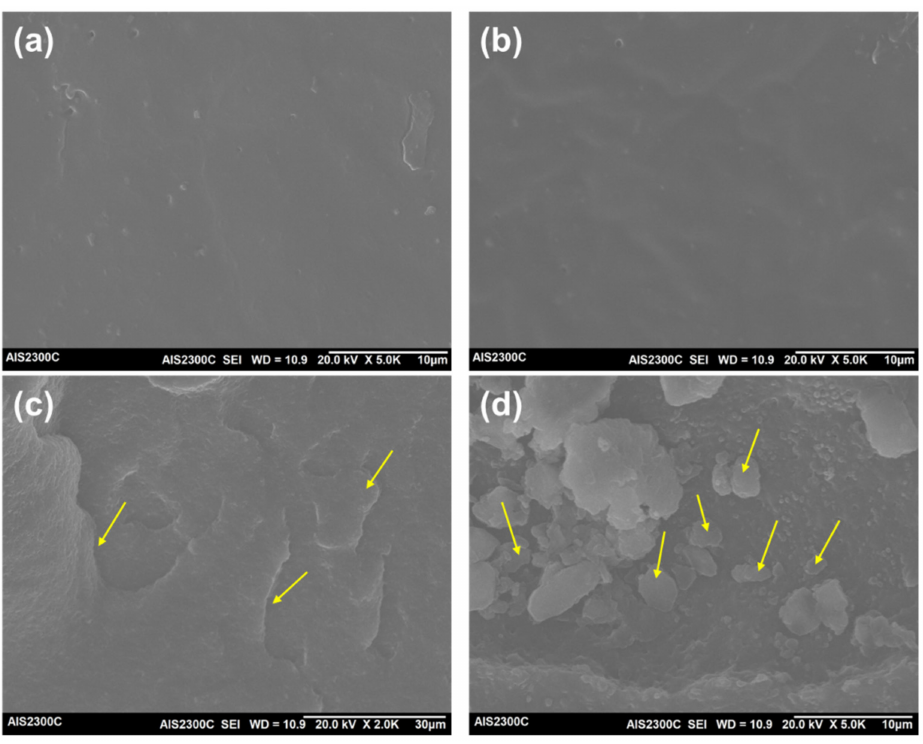
Figure 7. SEM images of the cryogenically fractured surface of the samples: ( a ) neat EPDM, ( b ) neat